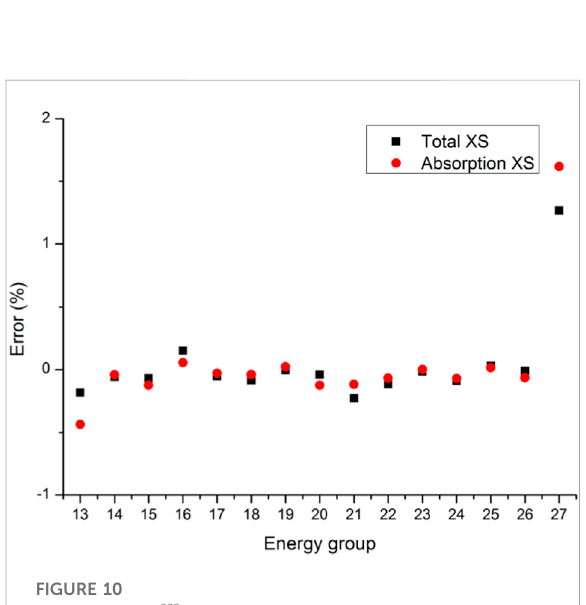
FIGURE 10 Comparison of 238 U total and absorption cross sections in Region